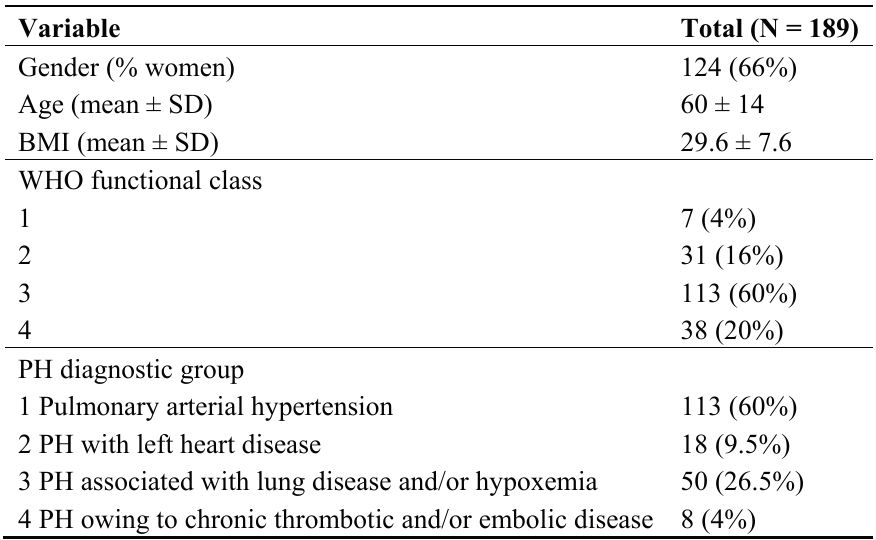
Table 1. Pulmonary Hypertension Demographics.